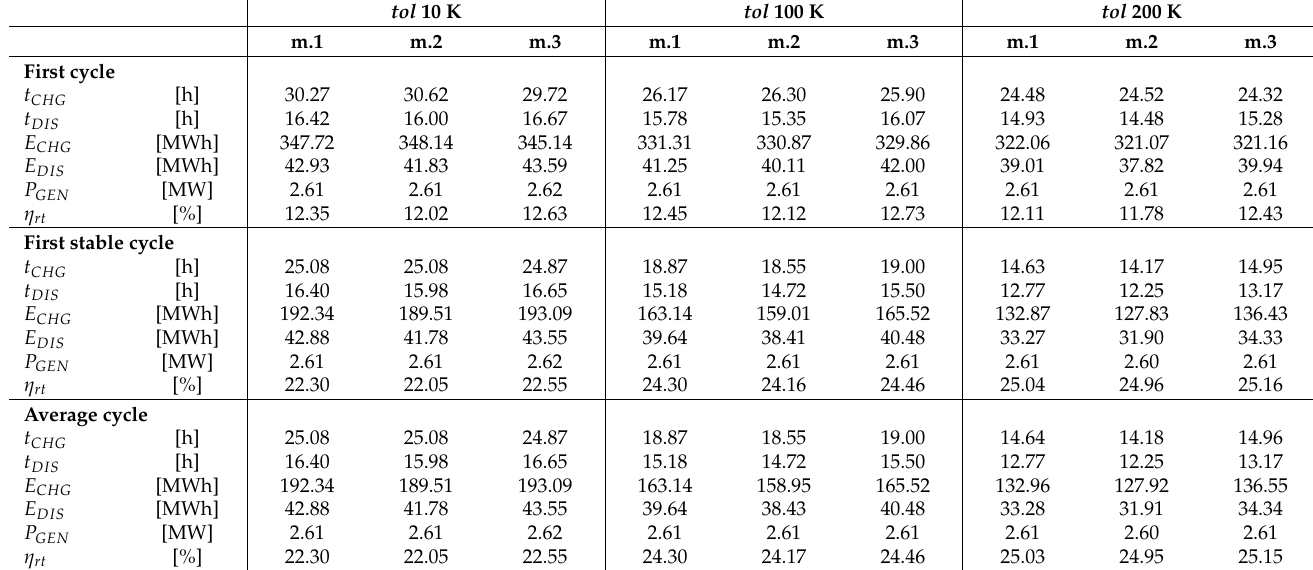
Table 2. Comparison between models when assuming different charging tolerances. The charging tolerance, which is the temperature difference between the cycle’s maximum temperature and the air temperature at the tank’s outlet, was set equal to 10, 100 and 200